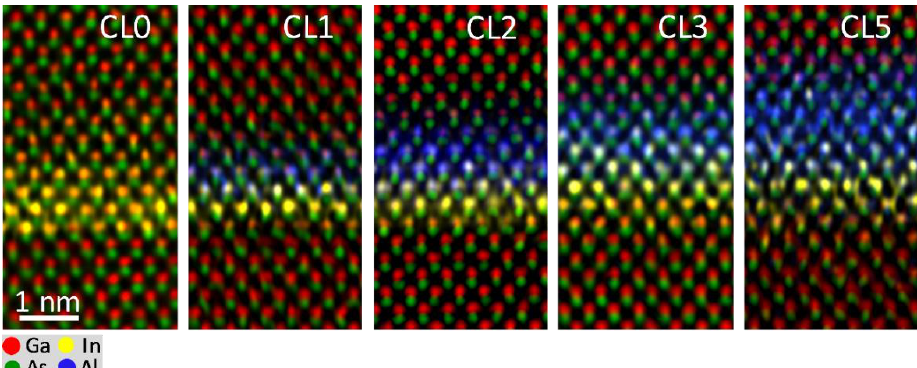
Figure 4. Atomic-level-resolution EDX elemental maps of WL/CL regions for the different InAs QD layers with 0, 1, 2, 3, and 5 ML of AlAs acquired along the [110] zone axis. Several composition profiles, from regions with sample thicknesses below 50 nm, along the growth direction were averaged using different EDX maps for each QD